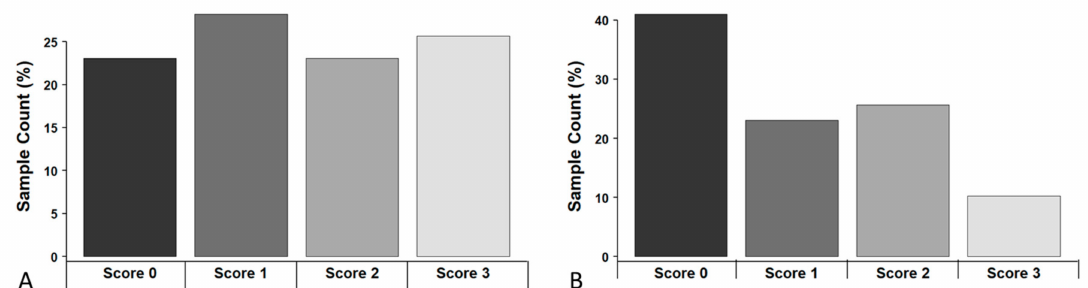
Figure 3. Distribution of IHC expression, based on the semi-quantitative scoring system; ( A ) CXCR4, and ( B )